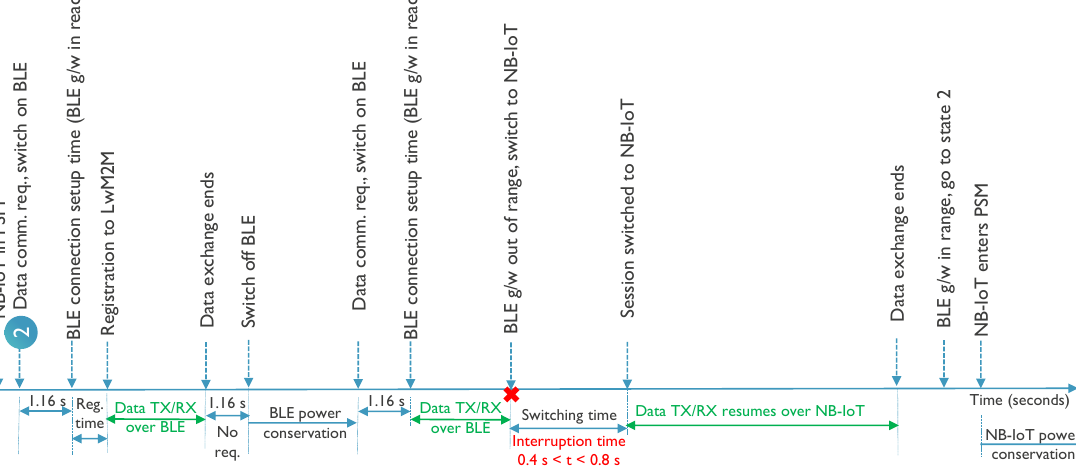
Figure 9. Passive handover from BLE to